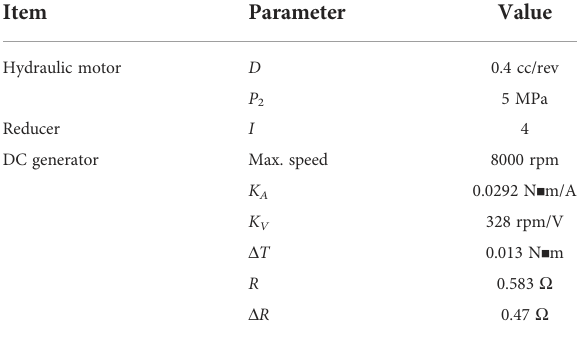
TABLE 1 The component parameters used in the experimental platform of energy conversion system.